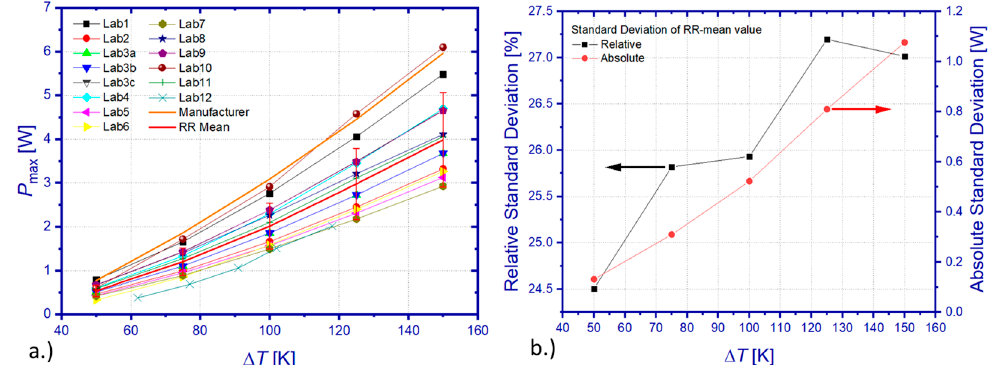
Figure 8. RR results for maximum power output P max in dependence on the temperature difference ∆ T in comparison to manufacturer specifications ( a ). The temperature-dependent mean value (RR mean) and its corresponding standard deviation have been calculated from all data sets. The absolute standard deviation is indicated as error bars ( a ) and shown separately together with the relative standard deviation ( b ).